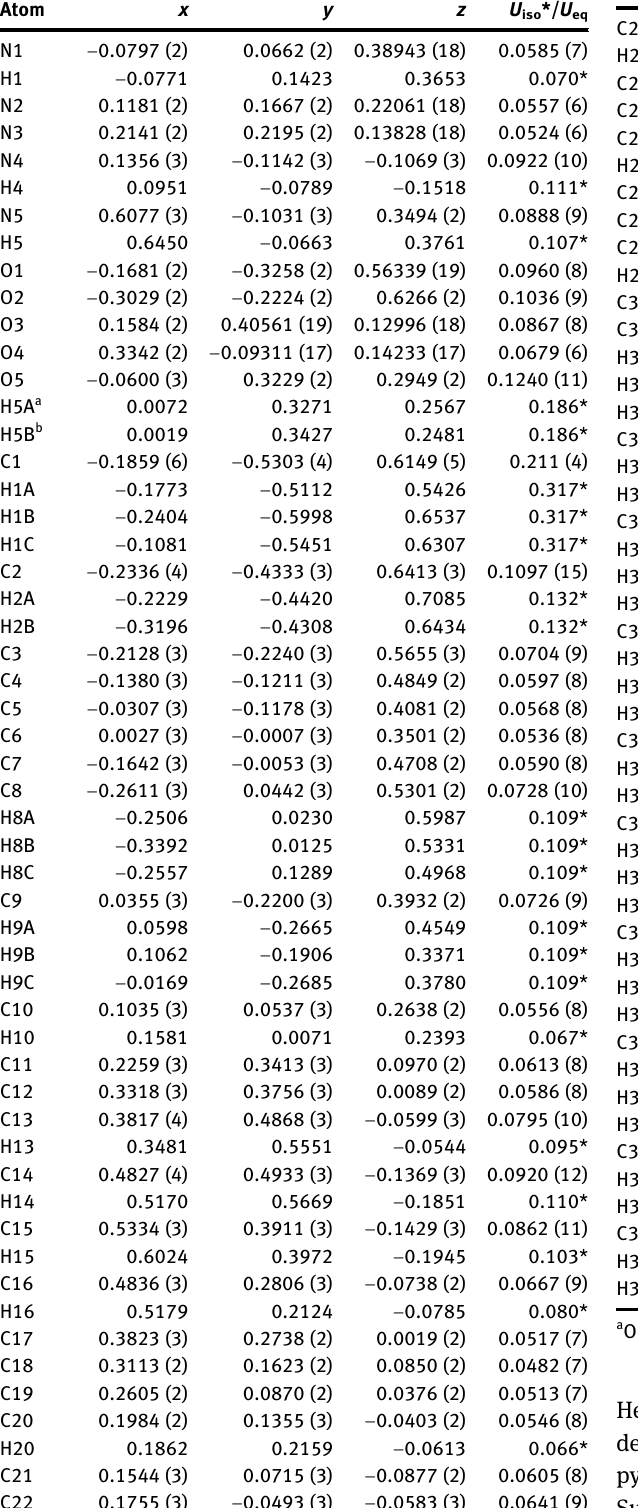
Table  : Fractional atomic coordinates and isotropic or equivalent isotropic displacement parameters (Å 